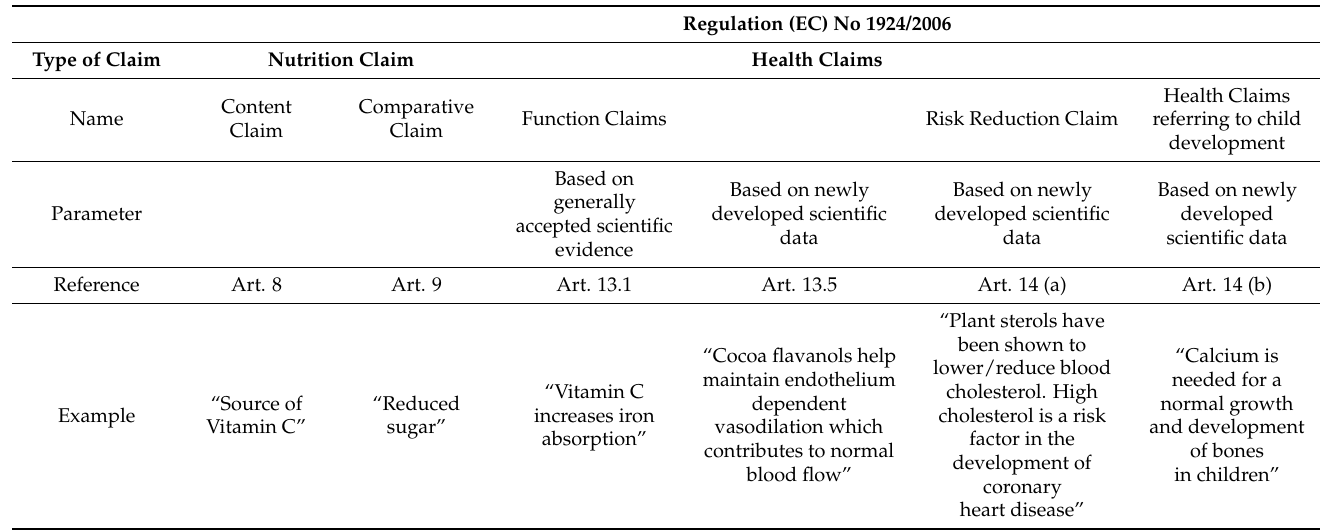
Table 1. Explanation and examples of nutrition and health claims as provided for in Regulation (EC) 1924/2006 [20] Reproduced from [20] with permission from Taylor & Francis Online, 2022 (www.tandfonline.com, accessed on 5 April